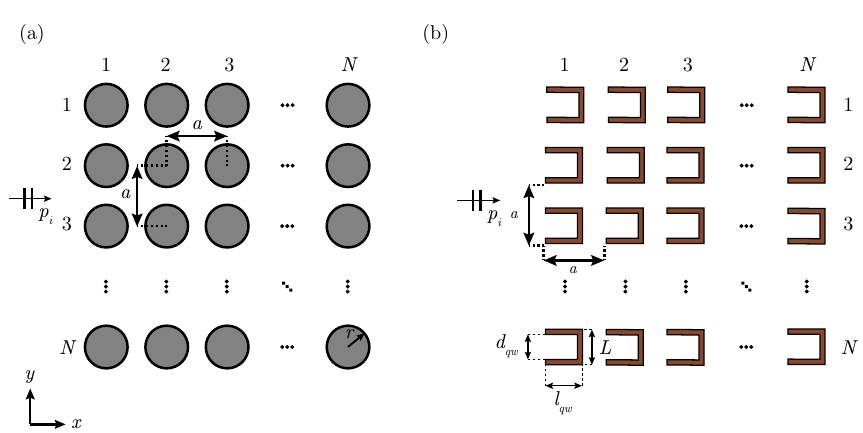
Figure 1. Set-up of the numerical experiments used to calculate the complex dispersion relation: ( a ) 2D SC composed of N × N cylindrical scatterers arranged in a square lattice. ( b ) 2D Metamaterial composed of N × N